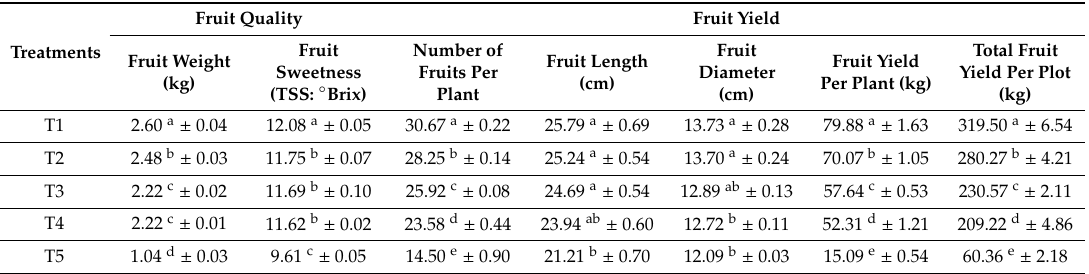
Table 7. Fruit quality and yield of papaya cv. Sekaki cultivated on a tropical peat soil treated with di ff erent amounts of CZ and NPK